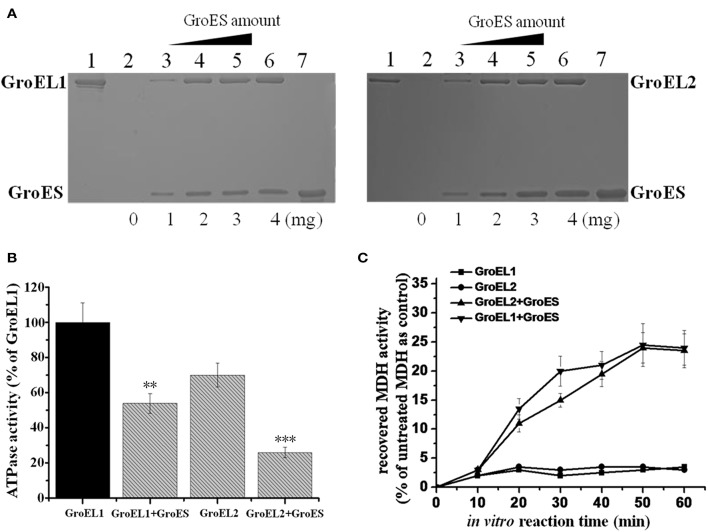
In vitro binding and refolding activities of GroELs and GroES from M. xanthus DK1622. (A) GroEL1 (left) and GroEL2 (right) proteins bound by the His-tag GroES-containing nickel column. Bound GroEL-GroES complexes were eluted from the column with 500 mM imidazole and assayed by SDS-PAGE. Line 1, GroEL1 and GroEL2 proteins that passed through the His-tag GroES column; lines 2–6, increased His-tag GroES bound by the nickel column (0-4 mg) with the same amounts of GroEL proteins for each line; line 7, GroES control with no GroEL. (B) ATPase activities of GroELs in the absence or presence of GroES. For statistical analysis, ***P < 0.001 and **P < 0.01, respectively. (C) MDH renaturation activities of GroELs in the absence or presence of GroES. Error bars in the pictures represent standard deviation of three time repeats.